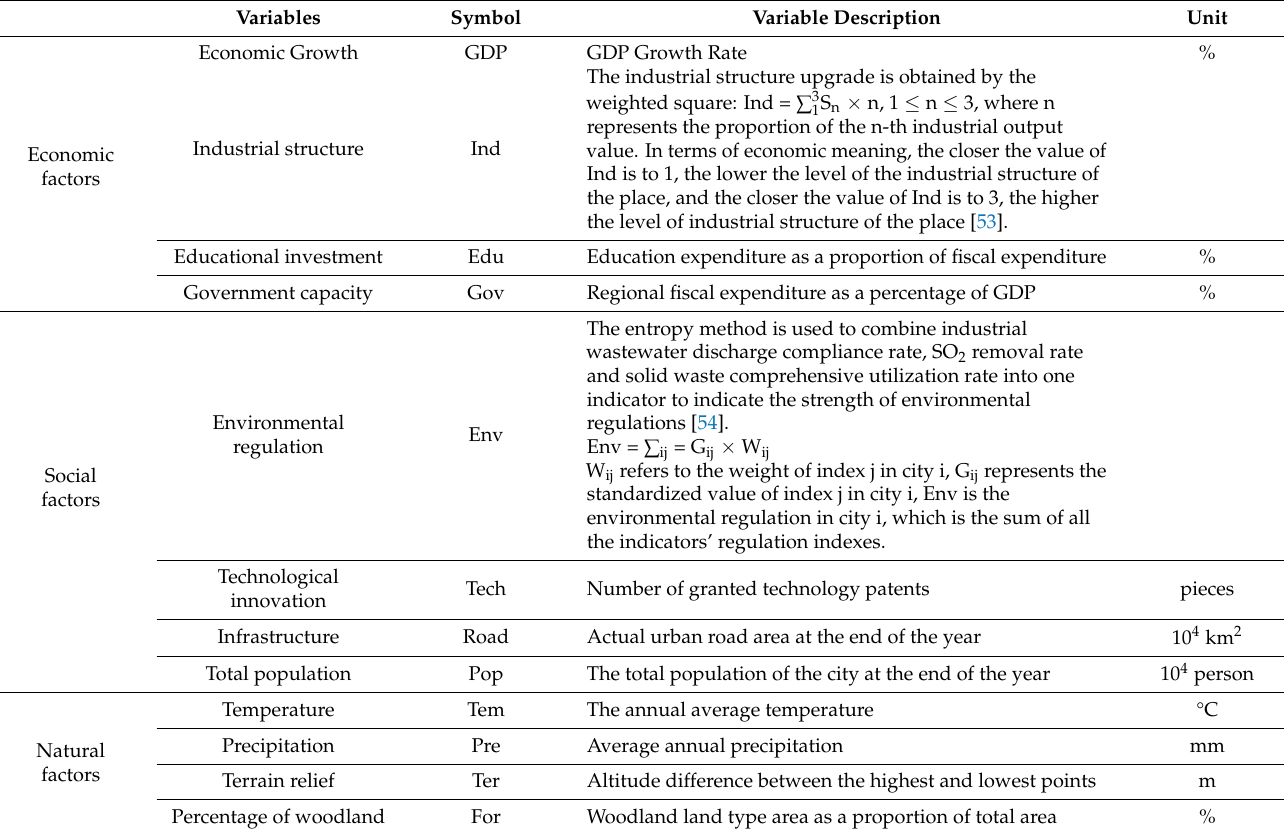
Table 2. Dynamic factors of coupling and coordination degree in the Yellow River Basin,